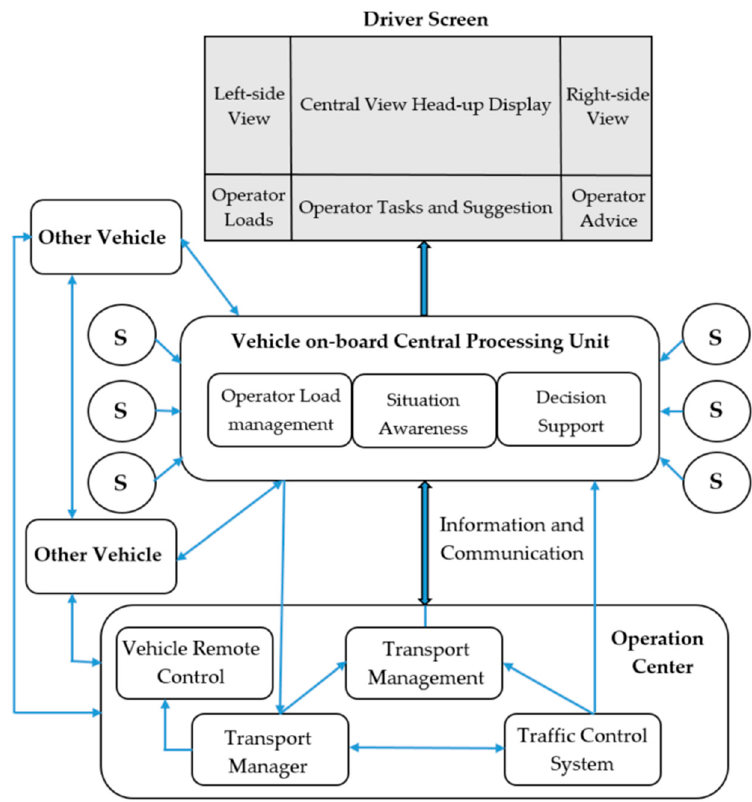
Figure 8. Functional model of the driver decision support system (s — sensors) .